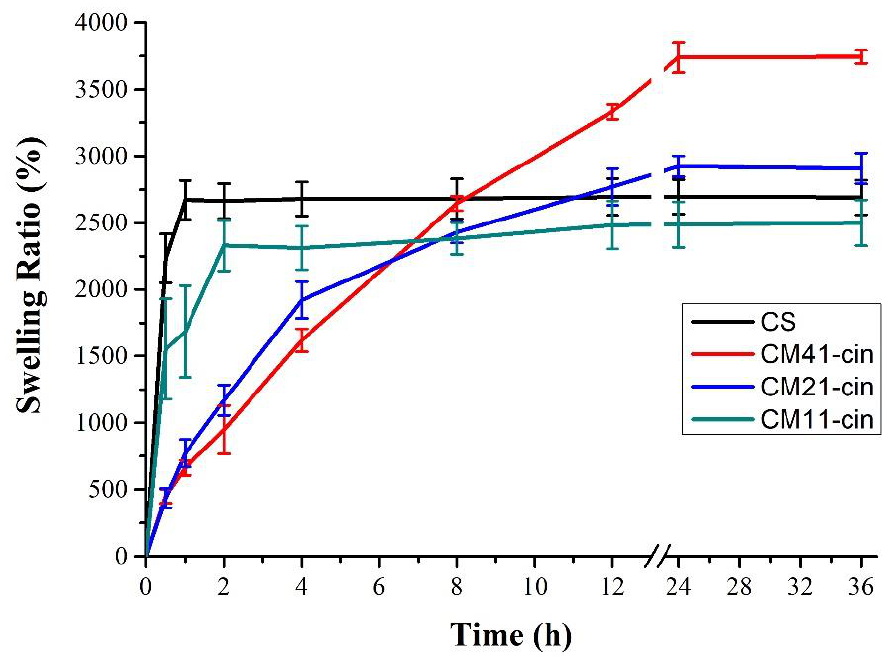
Figure 5. The swelling ratio of different hydrogels versus time. ( n = 3). For the non-crosslinked CS, it had a higher initial swelling ratio (<8 h) than the cinnamaldehyde-grafted crosslinked chitosan samples. This could be attributed to the hydrophobic nature of the grafted cinnamaldehyde. However, for a longer immersion duration (>24 h), the non-crosslinked CS presented a lower equilibrium swelling ratio than the CM41-cin and CM21-cin but a higher equilibrium swelling ratio than CM11-cin. The hydrogel prepared by the chitosan with less crosslinker added may allow the internal network to be more flexible and better able to accommodate the volume expansion due to PBS absorption as compared to the non-crosslinked CS hydrogel. Nevertheless, this equilibrium swelling ratio finding may be attributed to the synergistic effect caused by the degree of crosslinking and the amount of hydrophobic cinnamaldehyde grafted.